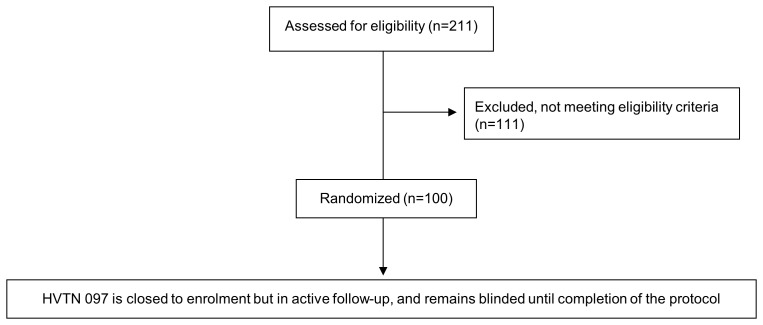
Flow diagram for HVTN 097 screening and enrollment.